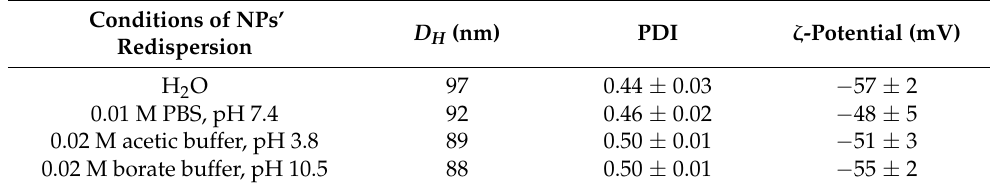
Figure 3. Scheme of preparation of PGlu@Ag ( A ) and Cys@Ag nanoparticles ( B ). Table 1. Characteristics of PGlu@Ag nanoparticles determined by dynamic and electrophoretic light scattering.